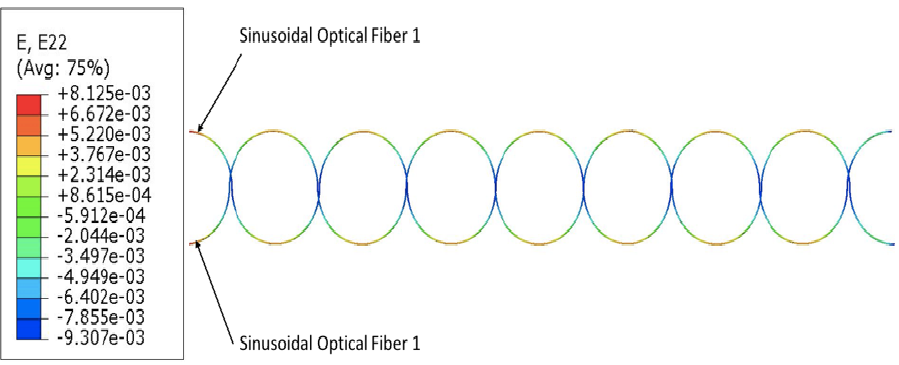
Figure 13 . Strain measurements showing dual-sinusoidal FOSs placement (placement in dual- sinusoidal mode, in phase opposition, provides coverage complementary to that of a single sinusoidal